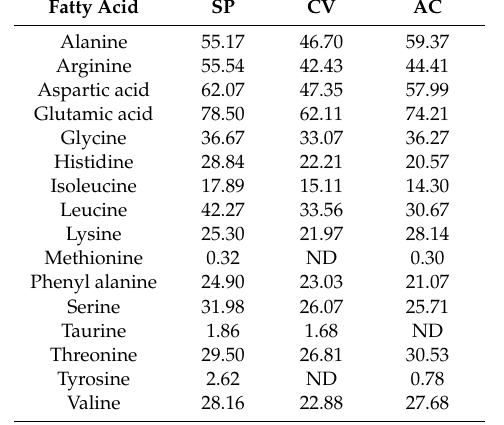
Table 3. Concentrations of amino acids (mg / g dried powder) in studied microalgae (SP, CV, and AC). Fatty